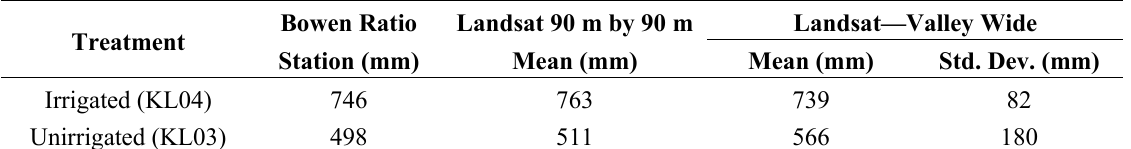
Table 2. Seasonal total evapotranspiration results at the irrigated and unirrigated